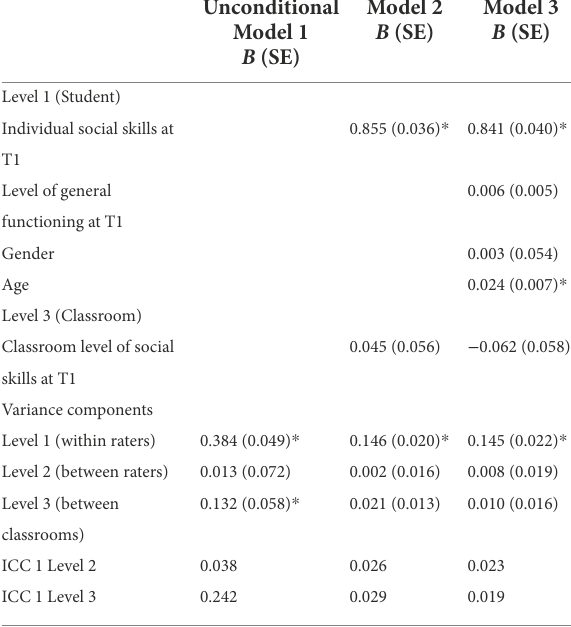
TABLE 4 Prediction of individual social skills at T2 from T1 classroom level of social